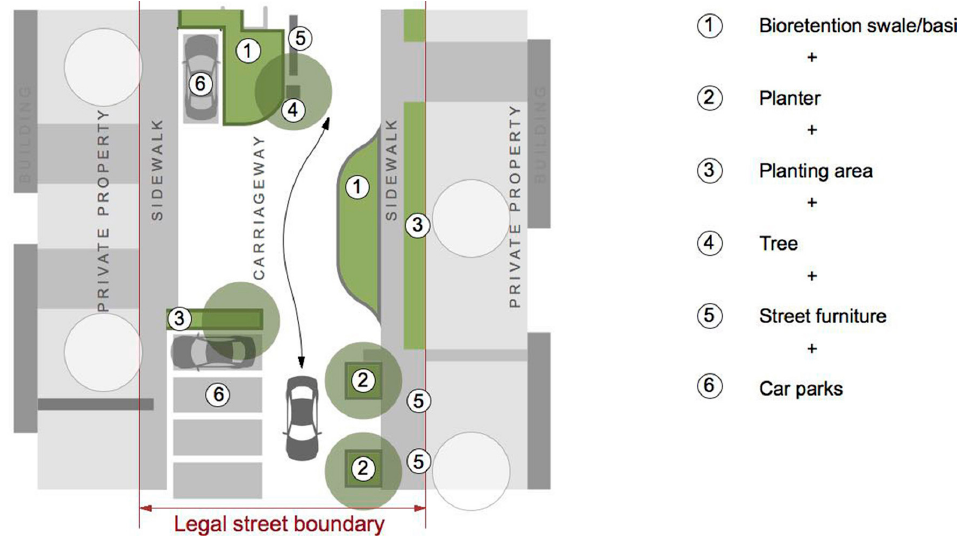
Figure 3. Example of physically integrated street infrastructure (plan view; not to scale).